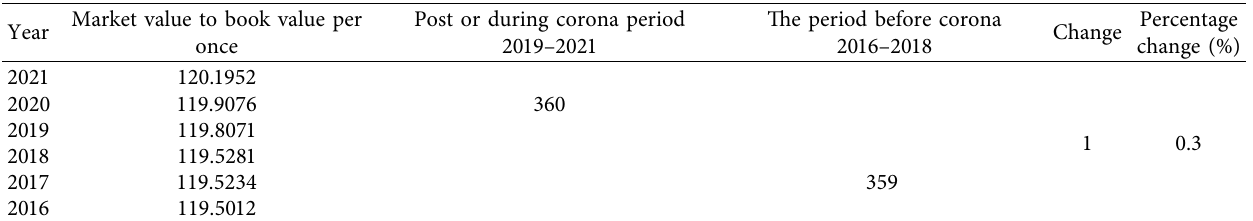
Table 7: Te evolution of the market value of the stock to the book value of the companies, a sample of the study, and before and after the efects of the Corona pandemic.